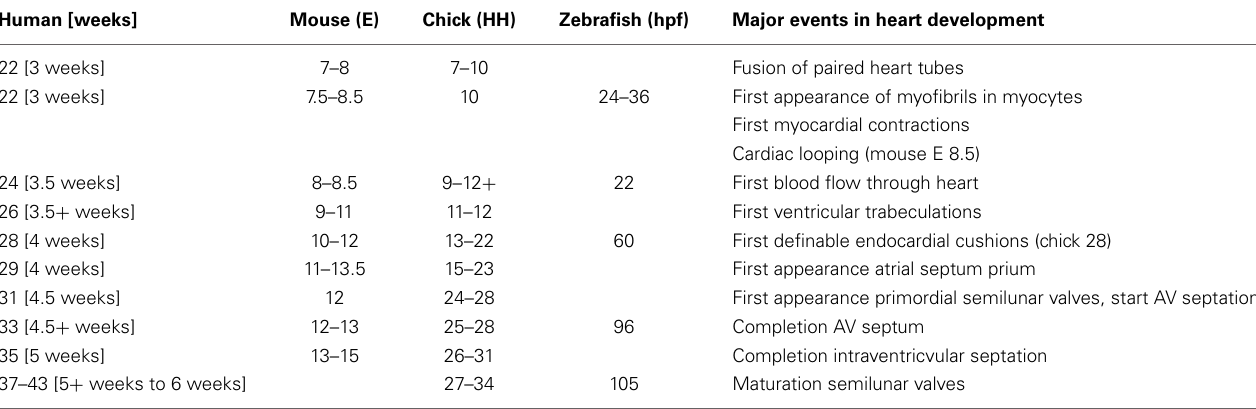
Table 1 | Comparative cardiovascular development across animal